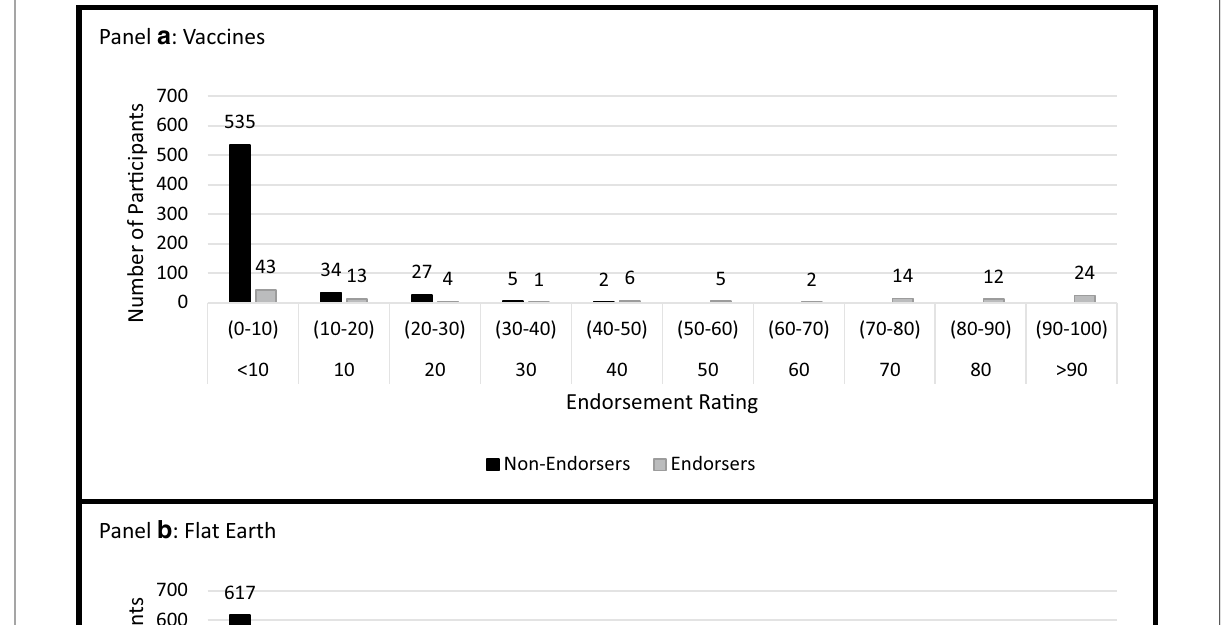
Panel b : Flat Earth